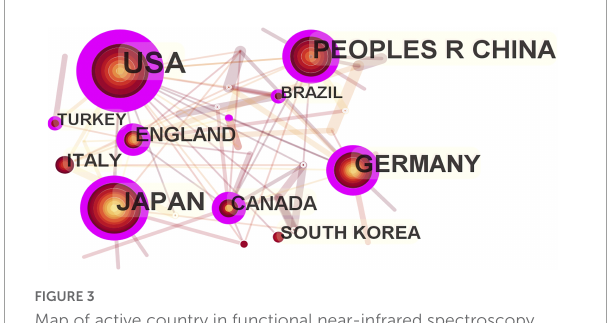
FIGURE3 Map of active country in functional near-infrared spectroscopy (fNIRS) research on diseases.